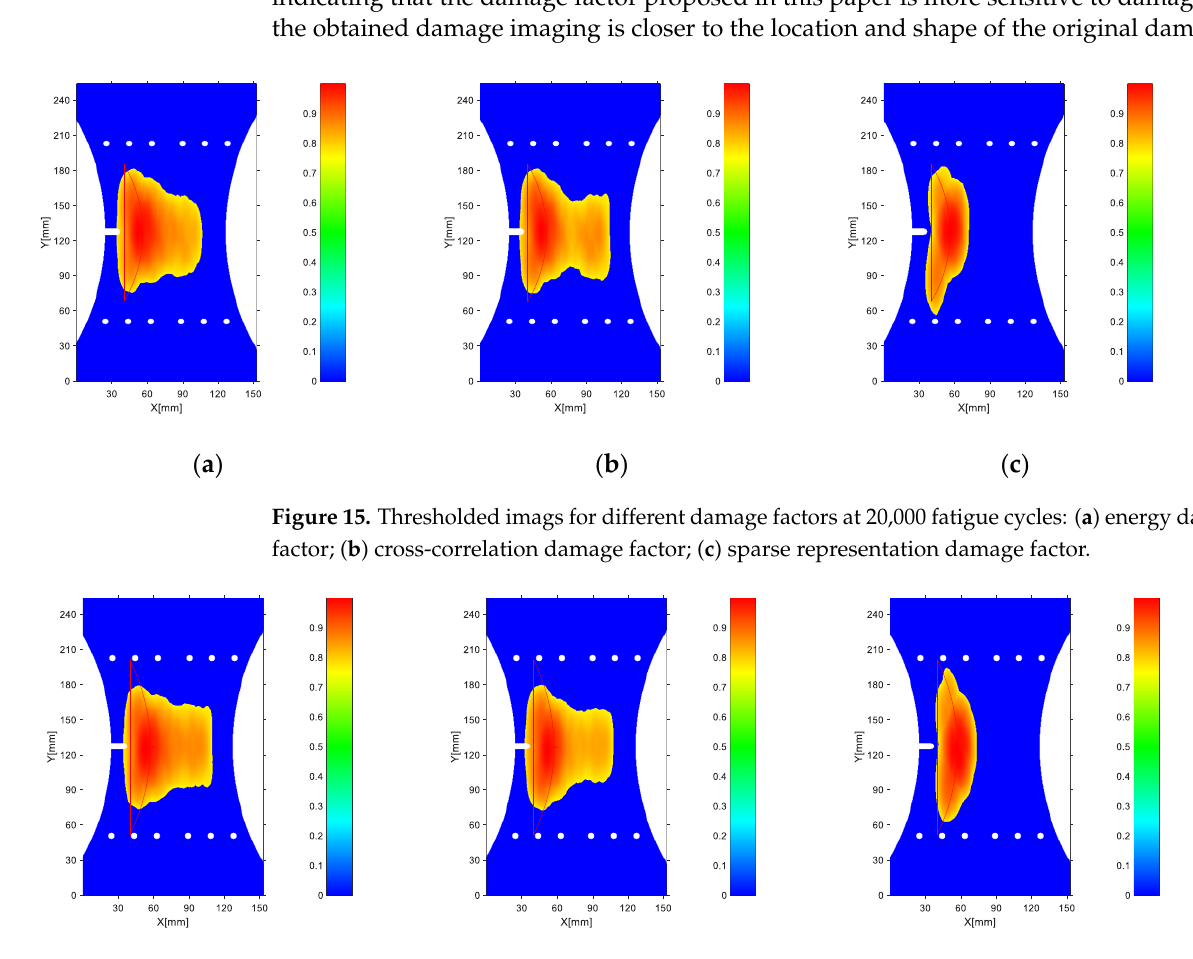
( c ) Figure 14. Images for different damage factors at 90,000 fatigue cycles: ( a ) energy damage factor; ( b ) cross-correlation damage factor; ( c ) sparse representation damage factor. To remove the interference information in the imaging results, threshold processing is introduced into the imaging algorithm. Because the damage probability value at the damaged location is large and the damage probability value at the damage edge is small,